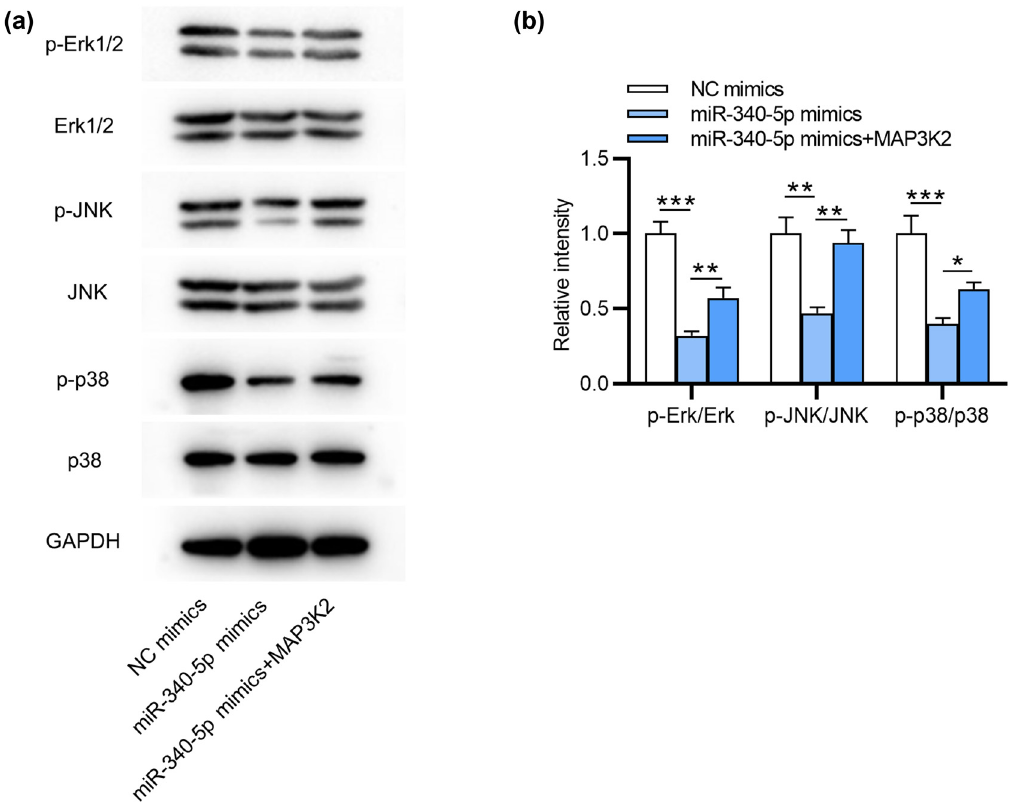
Figure 4: MiR - 340 - 5p represses endometriosis progression by regulating MAP3K2 - mediated MAPK/ERK pathway. ( a and b ) Western blotting of MAPK/ERK signaling pathway - related protein levels in ESCs. * p < 0.05, ** p < 0.01, *** p <